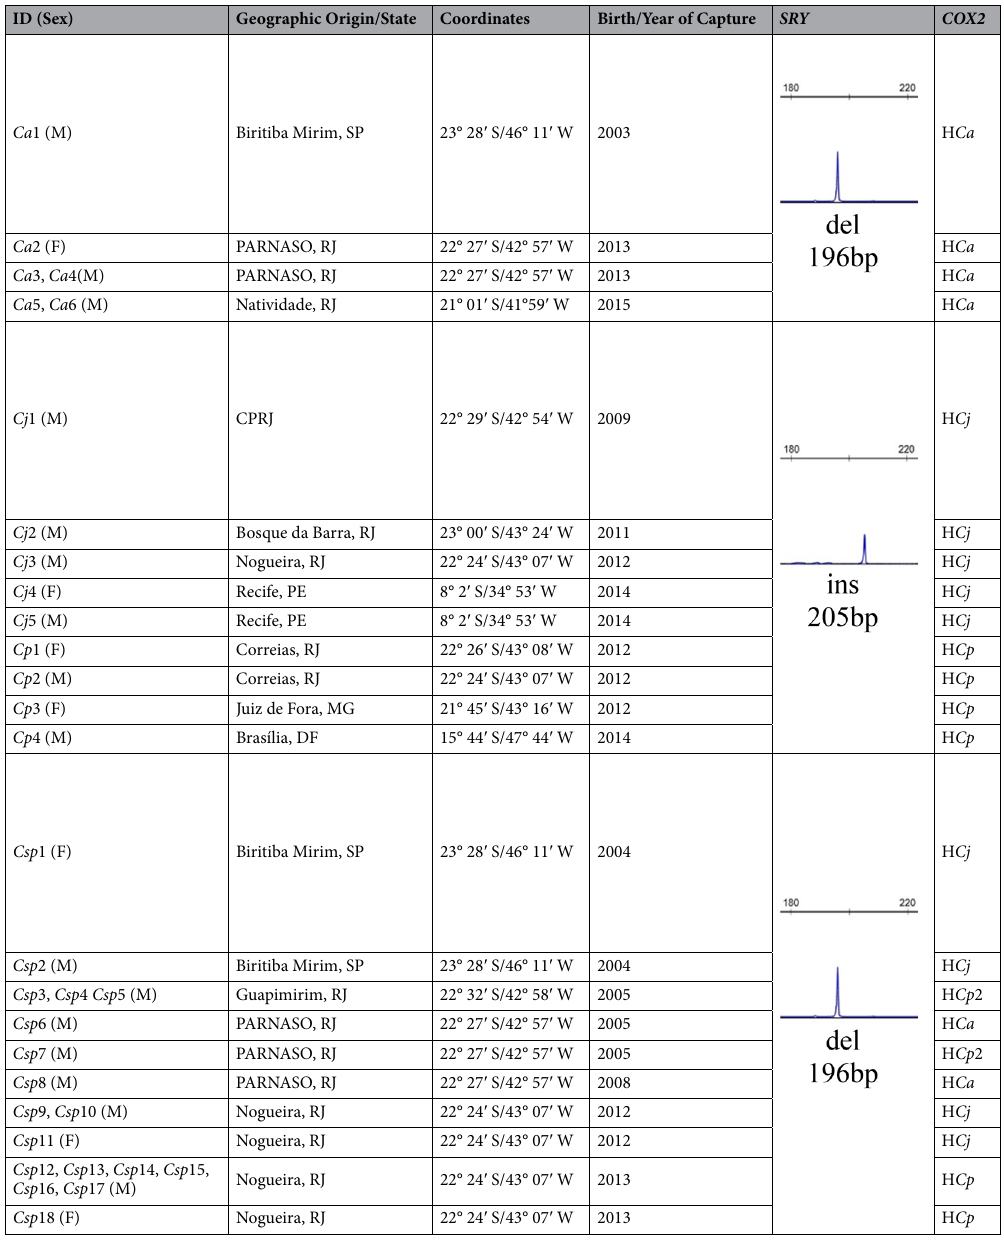
Table 1. Data concerning 18 Callithrix sp. ( Csp 1-18) and the positive controls sampled: C. aurita ( Ca 1-6), C. jacchus ( Cj 1-5) and C. penicillata ( Cp 1-4). For each sample, the electropherogram of the fragment of the SRY gene and the COX2 haplotype amplified (patrilineal and matrilineal lineage, respectively) is shown. ID- sample identification; M - Male; F - Female; H Ca - COX2 haplotype of C. aurita ; H Cj - COX2 haplotype of C. jacchus ; H Cp and H Cp2 - COX2 haplotype of C. penicillata; del - SRY deletion of nine base pairs with an electropherogram peak of 196 base pairs (bp); ins - SRY insertion of nine base pairs with an electropherogram peak of 205 bp; RJ - Rio de Janeiro state; SP - São Paulo state; PARNASO - Serra dos Órgãos National Park, Teresópolis, RJ,